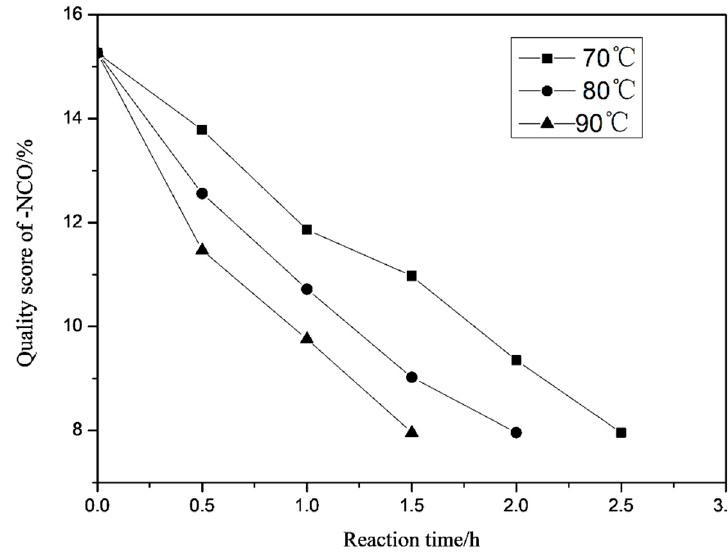
Figure 11. Effect of reaction temperature on -NCO conversion rate.